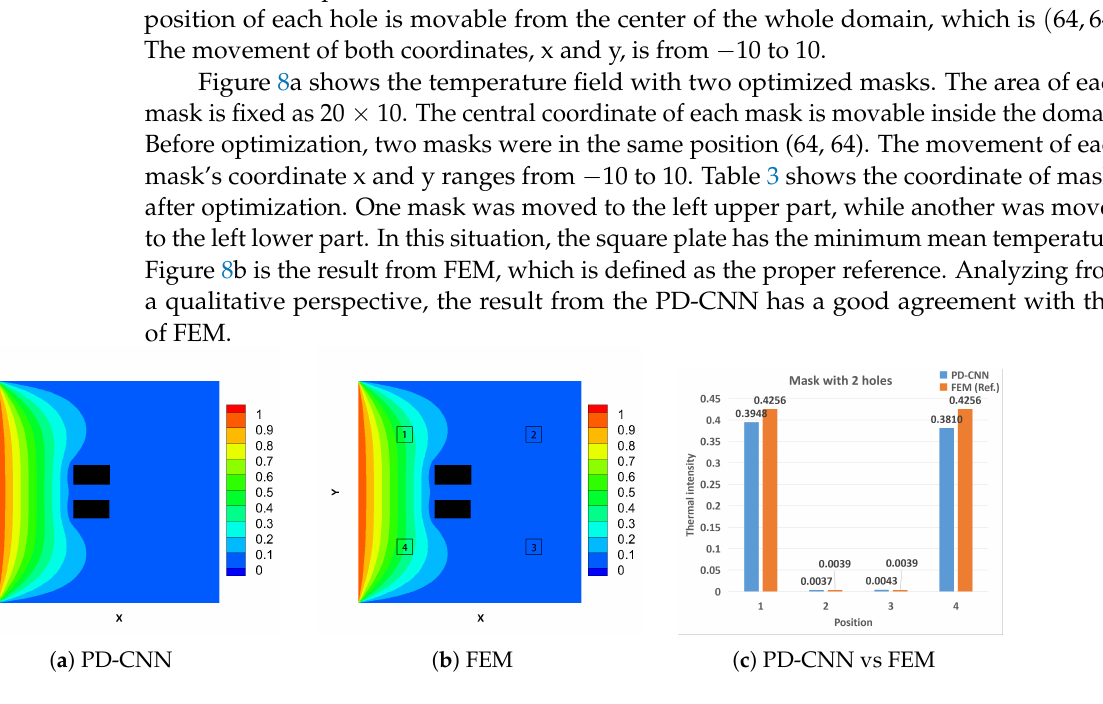
Figure 8. Comparison between surrogate model prediction and FEM result for the two-holes case. ( a ): Temperature field with an optimized mask using a CNN surrogate model; ( b ): Temperature field with an optimized cover using the FEM method; ( c ): quantitative comparison of the two results. Table 3. The position optimization of the two-holes